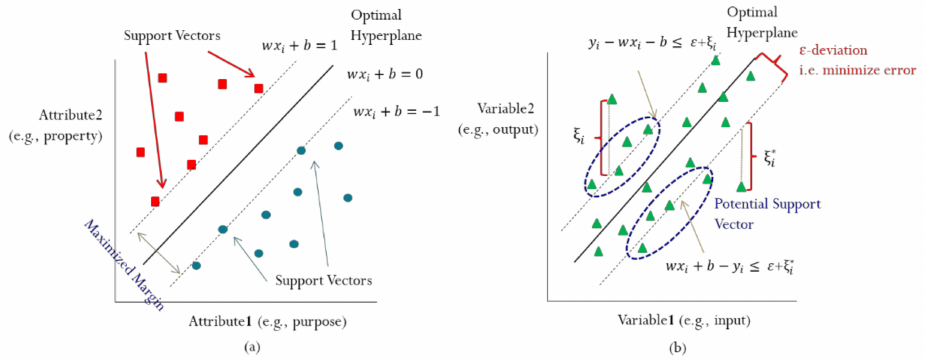
Figure 1. Overview of SVM algorithm: ( a ) SVM for classification; ( b ) SVM for